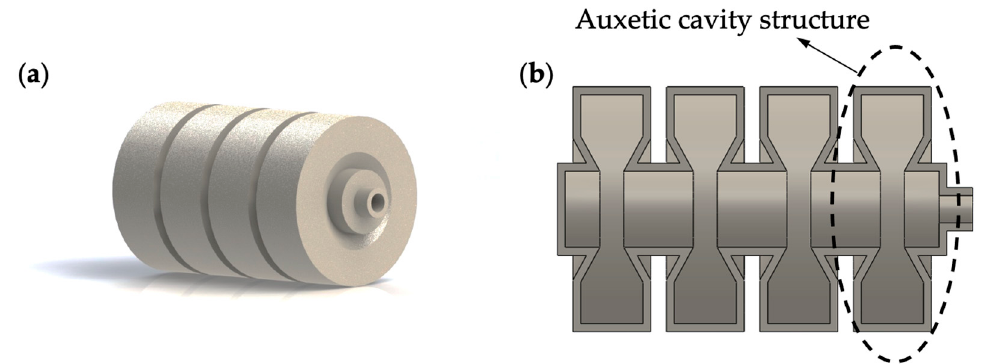
Figure 2. Single-channeled actuator. ( a ) Three-dimensional view; ( b ) sectional view.